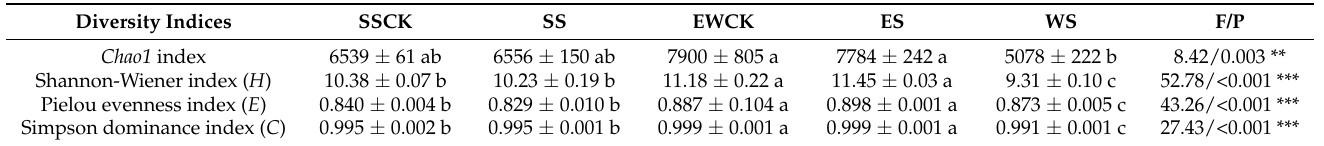
Table 2. Community diversity indexes of soil microbial microorganisms under the intercropped maize ecological shading in a tea